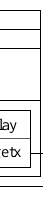
Figure 10. Trait-class